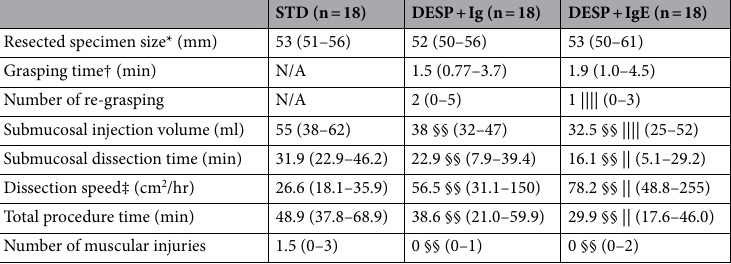
Table 2. ESD procedural outcomes at the Ascending colon using STD, DESP + Ig, and DESP + IgE. Median value (range). STD: standard ESD technique, DESP: double-balloon endolumenal surgical platform, Ig: interventional grasper, IgE: Ig with elbow. * The longest diameter of resected specimen. † Time from Ig insertion through the tool channel to grasping the lesion. ‡ (major radius) x (minor radius) π/ (dissection time). § vs STD, p < 0.05, §§ vs STD, p < 0.01, || vs Ig, p < 0.05, |||| vs Ig, p <